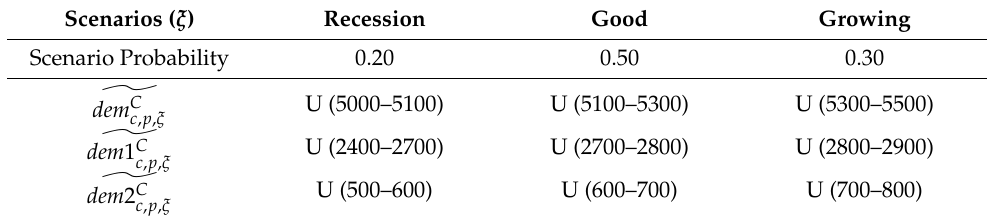
Figure 4. Location of the existing and potential facilities. Table 3. Values for scenario-based parameters (demands).